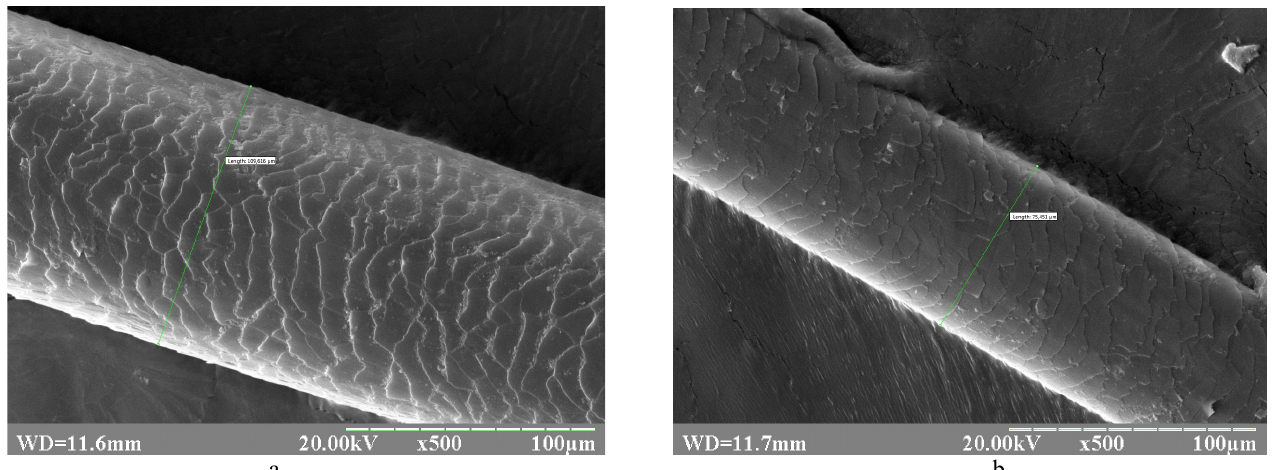
Figure 5. Horse hair ( Equus caballus ): а – male; b – covering